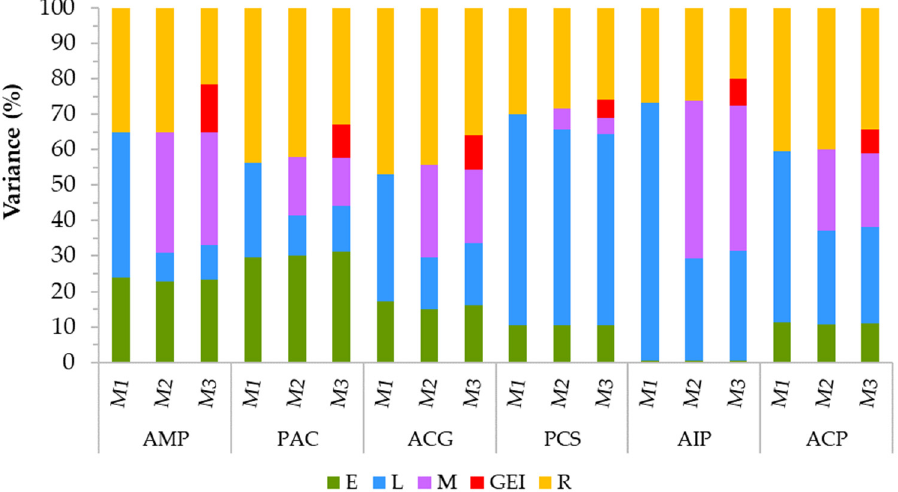
Figure 2. Partitioning of total variance components into environments (E), genotypes (L), molecular markers (M), interactions between genotypes and environment (GEI), and residual (R) components using the baseline M1 model, the main effect reaction norm M2 model, and the M3 model that incorporated GEI. Population codes are as follows: AMP (diversity panel), PAC (Peace/Carberry), ACG (Attila/CDC Go), PCS (Peace/CDC Stanley), AIP (AAC Innova/AAC Proclaim), and ACP (AAC